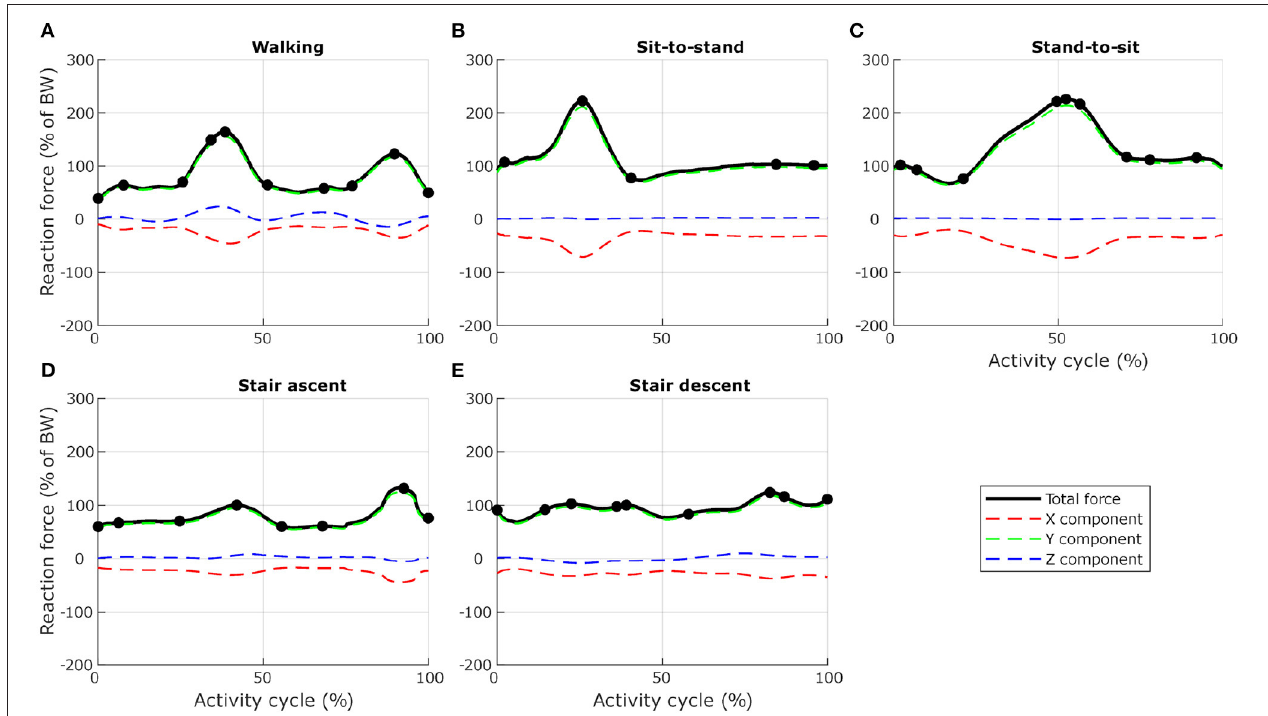
FIGURE 3 | Selection of load cases for L4, for five activities related to locomotion ( (A) level walking, (B) standing up from a chair, (C) sitting down on a chair, (D) walking up the stairs, and (E) walking down the stairs). Total reaction force at L4–L5 joint derived from the musculoskeletal model and normalised to body weight (BW) are shown as black lines. Dots indicate the frames selected for the finite element analysis. Red, green, and blue dashed lines show X, Y, and Z components of the reaction force expressed in the vertebra coordinate